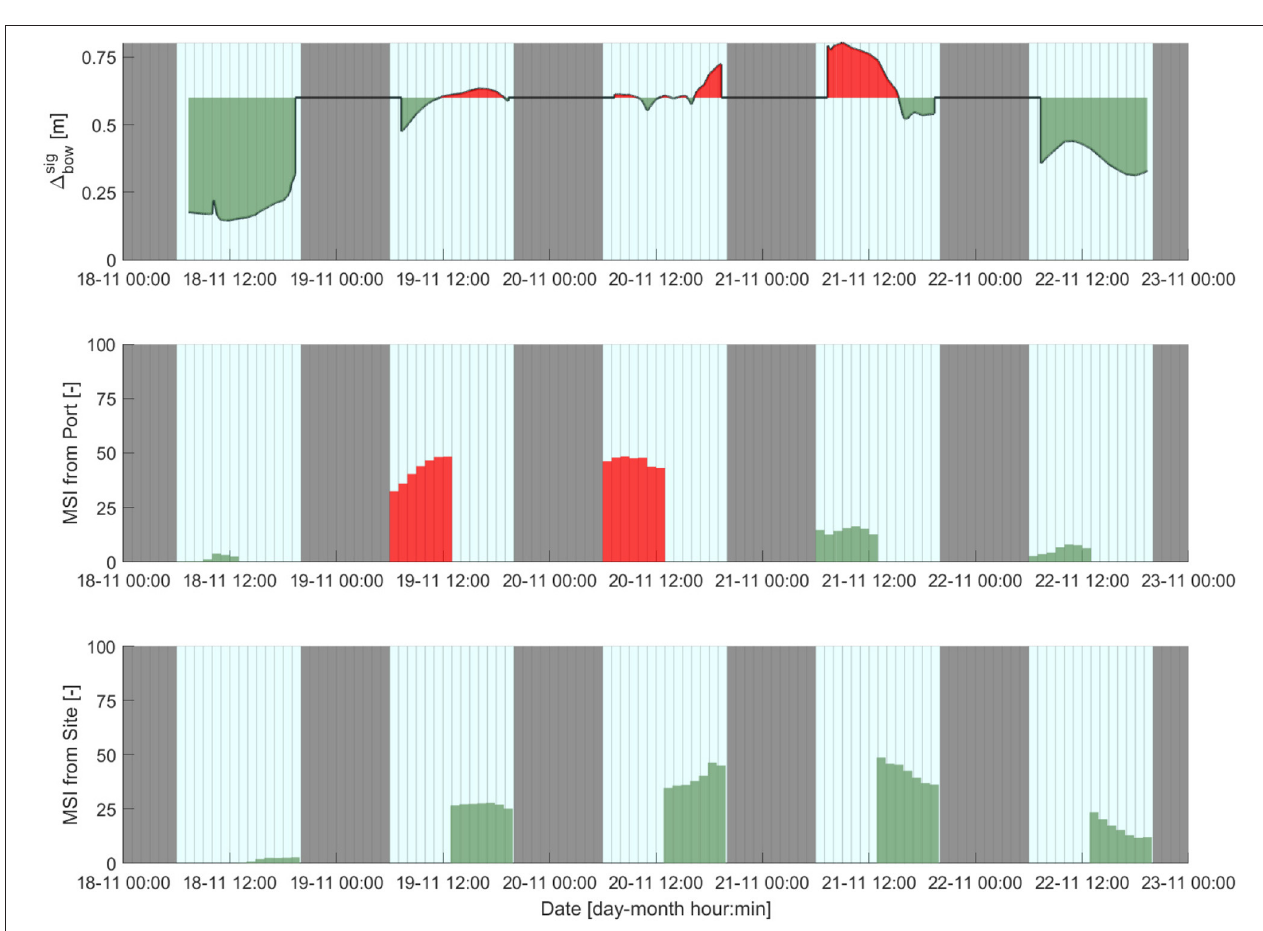
FIGURE 10 | Weather windows for the 5-day forecast 18th–22nd November 2018. From top to bottom panel: significant vertical displacement of the vessel bow 1 sig bow at the Site, maximum Motion Sickness Index (MSI) during the trip from the Port to the Site, maximum MSI during the trip from the Site to the Port. Green color indicates values below threshold, red color above threshold. Night hours are in gray, day hours in